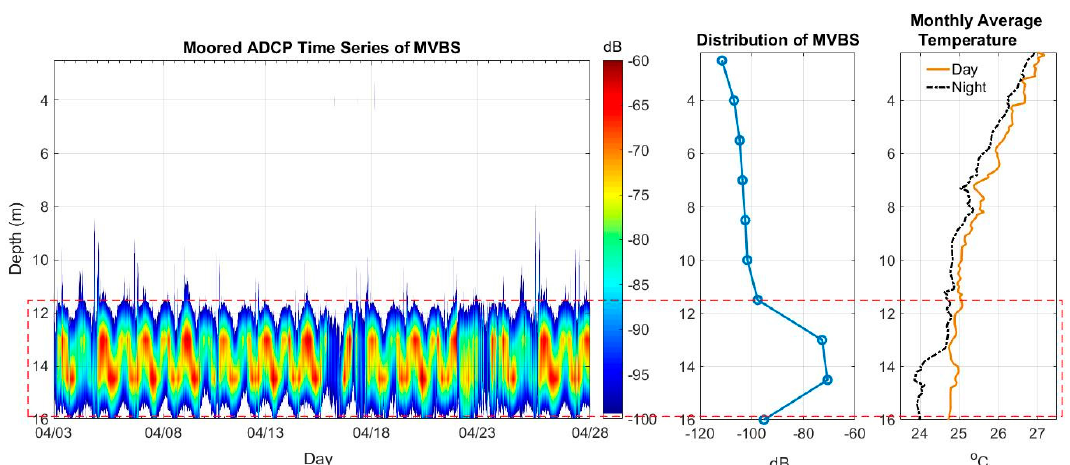
Figure 3. Time series (26 days) of filtered MVBS, the distribution of MVBS, and monthly average temperature. Yellow to red color in red square dashed line in 12 – 16 m of depth indicates the zooplankton movement during one cycle of the sun.